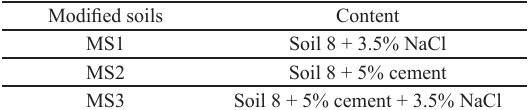
Table 2. Modified soils